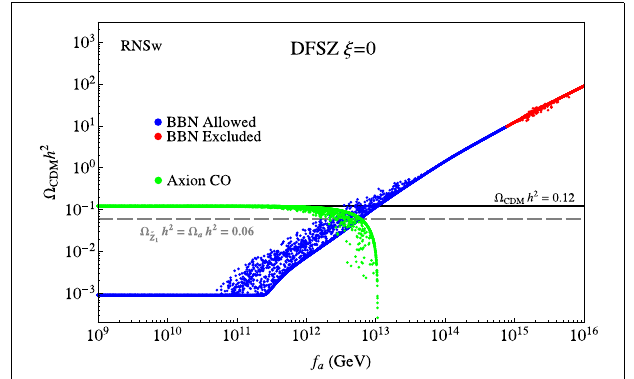
FIGURE 9 | The wino-like WIMP and axion relic densities from a scan over SUSY DFSZ parameter space for the RNSw benchmark case with ξ = 1 . The gray dashed line shows the points where DM consists of 50% axions and 50%